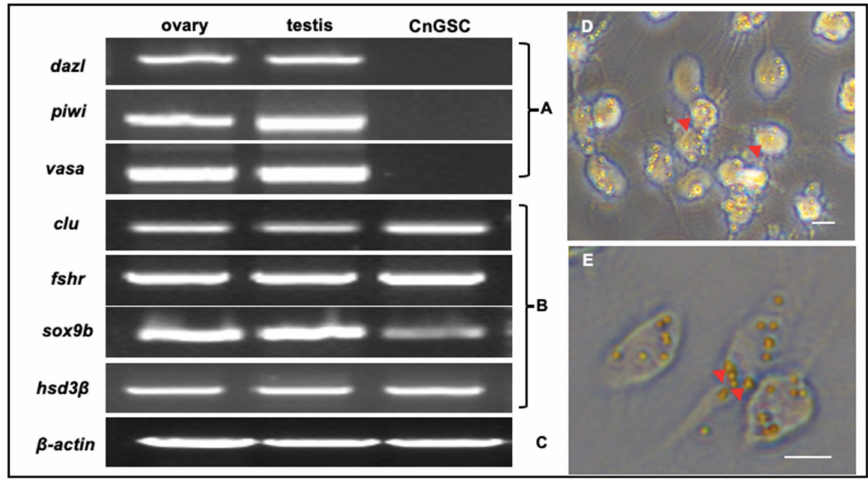
Figure 4. Characterization of CnGSC cells’ properties. ( A – C ) Gene expression pattern of CnGSC cells. ( A ) Absence of germ cell markers by RT-PCR with primers for dazl , piwi, and vasa . ( B ) Expression of somatic cell markers by RT-PCR of total RNA from gonad tissues and CnGSC cells. Sertoli cell markers: clu, fshr, sox9b ; Leydig cell marker: hsd3 β . ( C ) The β -actin gene was used as an internal control for RT-PCR. ( D , E ) Phagocytic activity. CnGSC cells showed phagocytic activity in terms of the uptake of latex beads. (Bars = 10 µ m in ( D , E